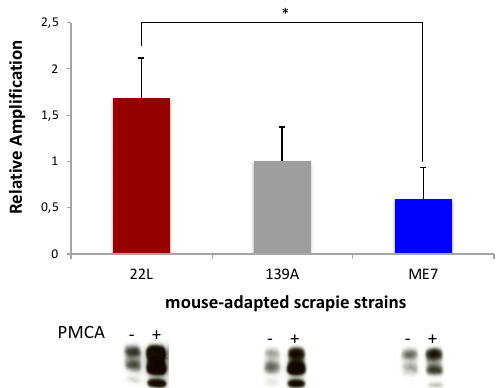
Figure 1. Neuronal strain tropism using in vitro models. Relative amplifications obtained with mouse-adapted scrapie strains (139A, 22L and ME7) using CGN lysates from C57BL/6 mice. PMCA-, no PMCA was applied. PMCA+, one round of PMCA was applied. Neuron-specific PMCA results are representative of four independent experiments performed in duplicates. Values for the three PrPres glycoforms were measured on blots with a non-saturated signal using a GS-800 calibrated densitometer and Quantity One software (Bio-Rad Laboratories). Relative amplification = [(PMCA+) – (PMCA-)]/(PMCA-) was calculated as a function of the value of the internal standard of amplification included in each experiment. For statistical comparisons between strains, the nonparametric Mann-Whitney test was used. Analyses were performed using SigmaStat (ver 3.5, Available online: https://systatsoftware.com). Data are presented as the mean +/ − SEM. * p <